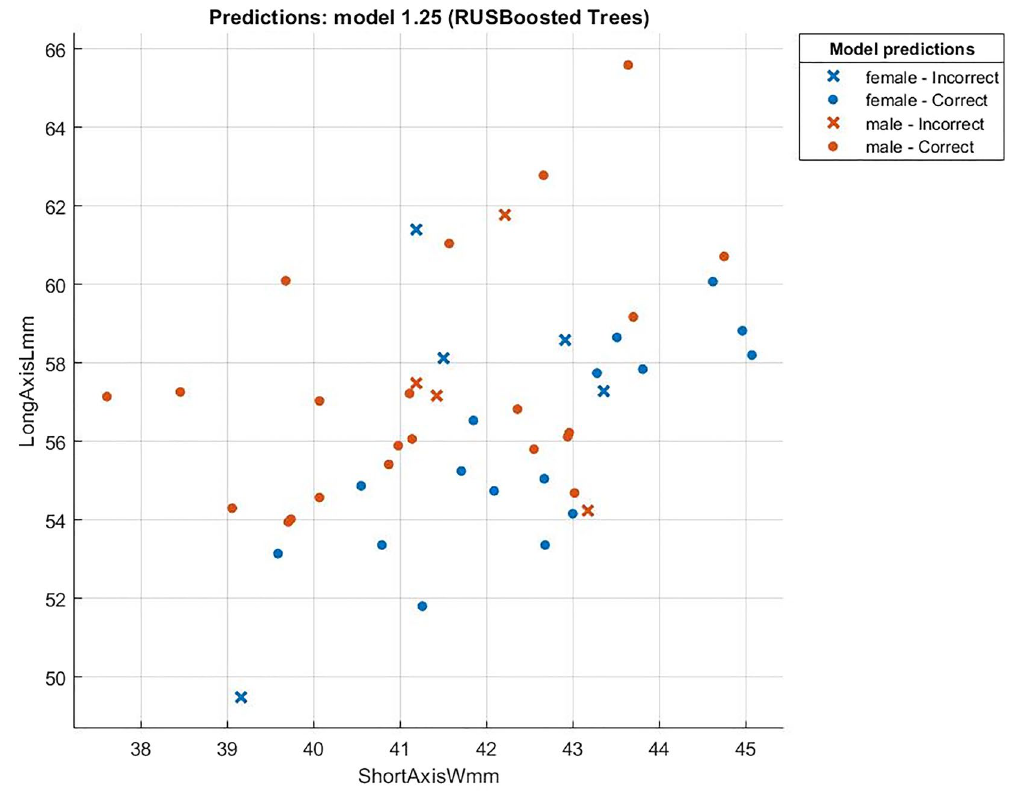
Figure 8. The relation between Short and Long Indexes. (r =